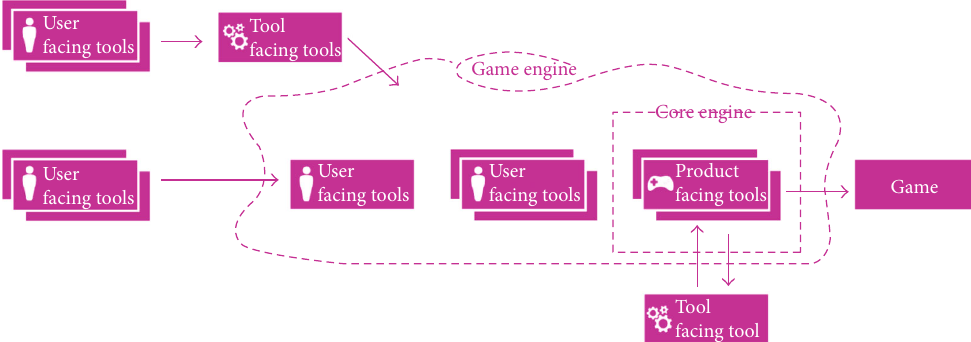
Figure 2: A model of a game development production